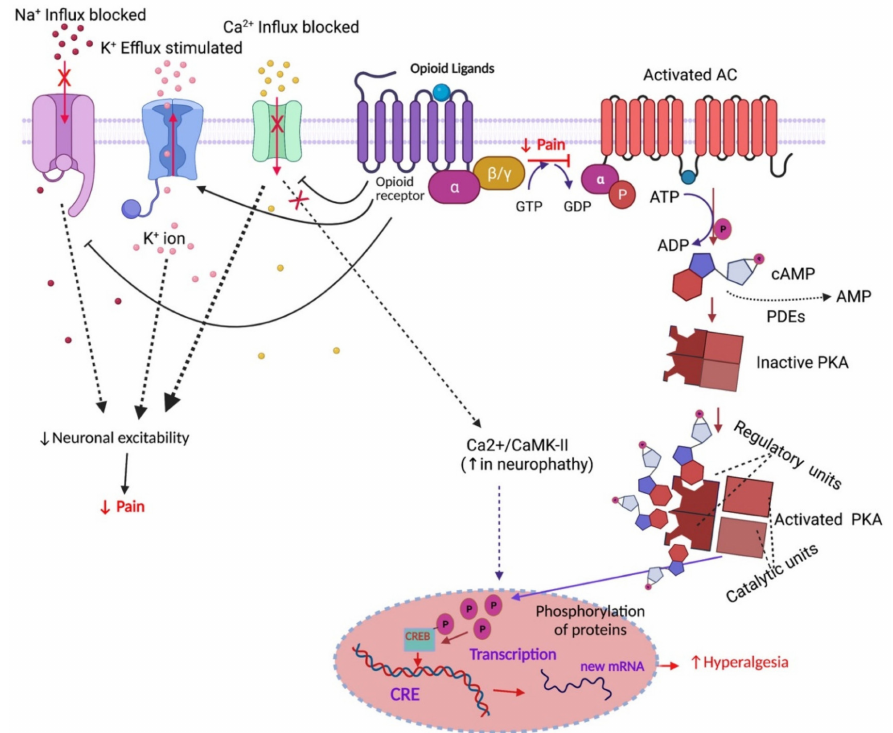
Figure 1. Effects of opioid agonists on pain and signal transduction. Abbreviations: ATP, adenosine triphosphate; ADP, adenosine diphosphate; GABA, gamma-aminobutyric acid; AMP, adenosine monophosphate; cAMP, cyclic adenosine monophosphate; PKA, protein kinase A; CRE, cAMP-responsive element; CREB, cAMP-responsive element binding protein; GTP, Guanosine triphosphate; GDP, Guanosine diphosphate; PDEs, Cyclic nucleotide phosphodiesterases; Ca2+/CaMK-II, Ca2+/calmodulin-dependent protein kinase II. Symbols: solid arrow, strong activation; dashed arrow, moderate activation; solid T-shaped line, strong inhibition; dashed T-shaped line, moderate inhibition, line with × , blocking; upward arrow, increased effect; downward arrow, decreased effect. The figure was made with www.biorender.com (accessed on 19 October